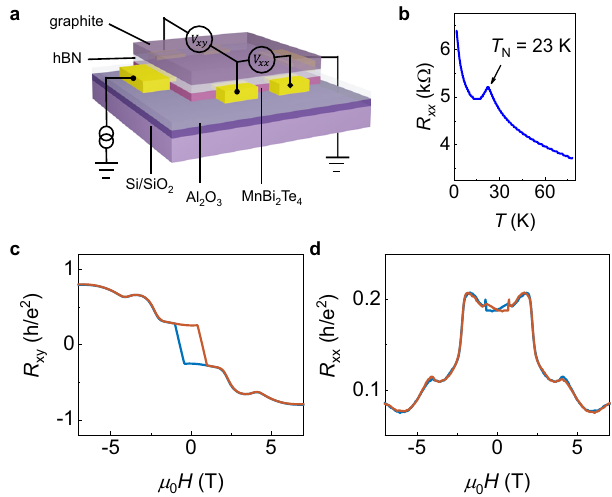
Fig. 1 | The characterization of MnBi 2 Te 4 devices. a The schematic structure of the MnBi 2 Te 4 device. The MnBi 2 Te 4 thin fl akes are obtained by Al 2 O 3 -assisted exfoliation method. Au electrodes are thermally deposited through stencil masks. Si/SiO 2 and graphite/hBN work as bottom and top gate, respectively. b The temperature-dependent resistance of a 5-SL MnBi 2 Te 4 (Device 1) device. The Néel temperature( T N ) is indicatedbya resistance peakaround 23K. c , d Thetransverse andlongitudinalresistanceasafunctionofthemagnetic fi eldat1.7KforDevice1.A top gate voltage of − 2V is applied to tune the Fermi energy to the charge neutrality